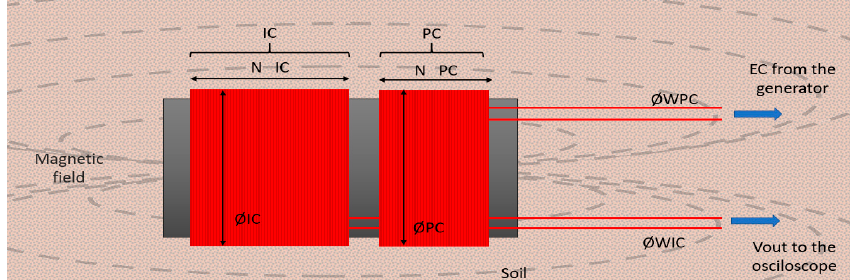
Figure 1. Scheme of the variables considered for our experiments.